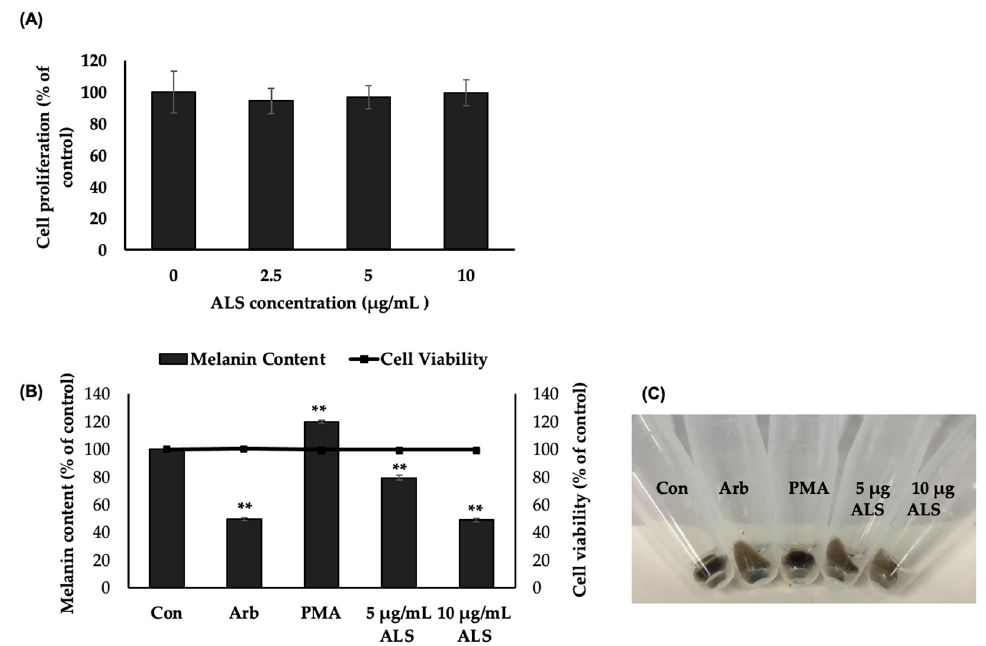
Figure 4. Effect of argan saponins fraction on cell proliferation and melanin content of human epidermal melanocytes (HEMs). ( A ) MTT assay was performed on HEM seeded at a density of 3 × 10 3 cells/well of a 96-well dish and treated with different concentrations of argan leaf saponins-rich fraction (2.5 µg/mL, 5 µg/mL, or 10 µg/mL). ( B ) Melanin assay was carried out on HEMs seeded at a density of 5 × 10 5 cells per 100 mm Petri dish treated with 5 µg/mL or 10 µg/mL of saponins-rich argan leaf sample (ALS), arbutin (Arb, 100 µM), or phorbol 12-myristate 13-acetate (PMA, 10 ng/mL) and incubated further for 48 h. ( C ) Photograph of HEM pellets before melanin assay was performed. Data are expressed as mean ± SD ( n = 5). **indicates significance at p < 0.01.